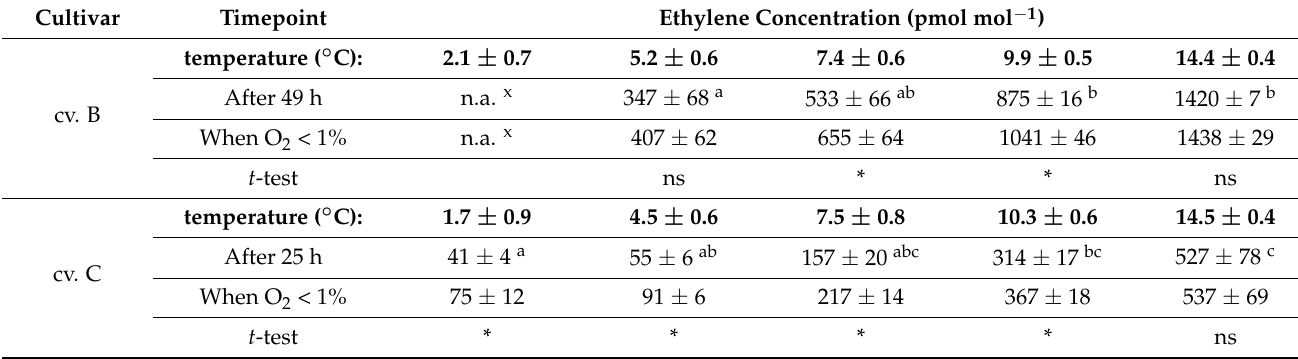
Table 5. Effect of temperature on the ethylene production of Chrysanthemum , in the headspace of bottles at two timepoints (one day (cv. C) or two days (cv. B) after closing the bottles and when O 2 concentration < 1%). Data are mean ± SD ( n ≤ 4). Cultivar Timepoint Ethylene Concentration (pmol mol − 1 )